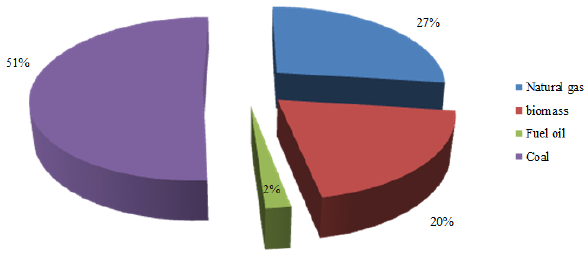
Figure 2: Percentage share of individual energy carriers used in single-family housing in central heating. Source: Own study.